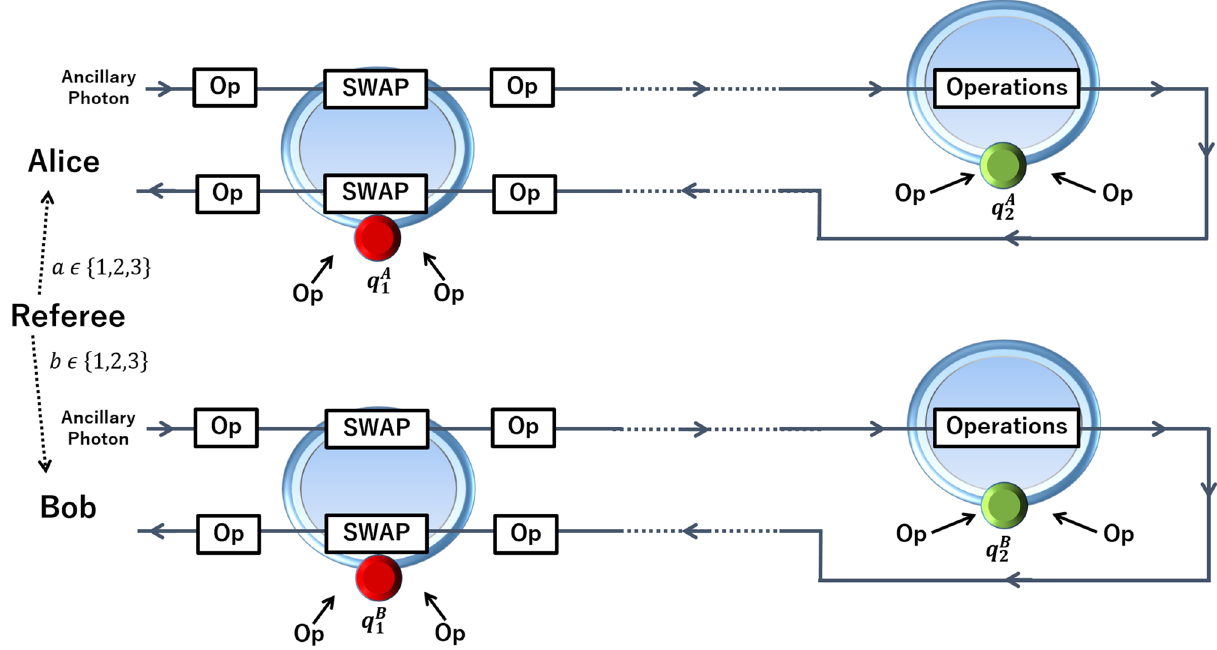
Figure 3. Proposed experimental setup for playing the game. Referee gives the number of row a (column b ) to Alice (Bob) to fill with binary entries. The initial four-qubit state given in Eq. (1) is a composition of two EPR pairs (one illustrated with red and the other with green circles) shared by Alice and Bob. Each quantum dot (red or green circles) coupled to an optical cavity (blue toroids) constitutes one logical qubit. Following the extension strategy in Fig. 1, each two-qubit operation (given in Eqs. 2 and 3 ) on the logical qubits (distant quantum dots) is realized via an ancillary photon traveling between the optical cavities as: Following a SWAP